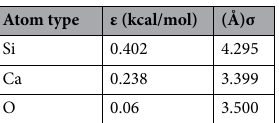
Table 1. Lennard–Jones potential coefficients are used in this